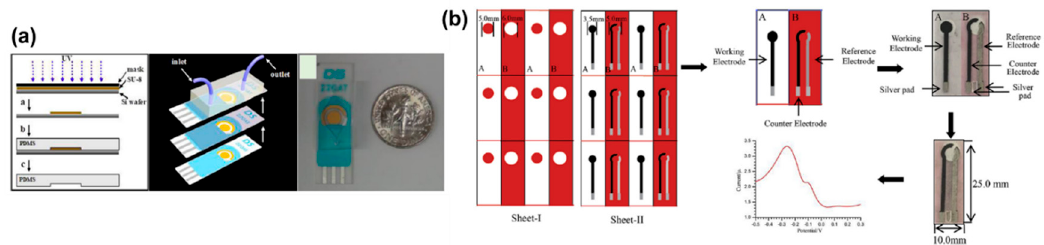
Figure 20. ECBs for the sensitive detection of PSA and cancer antigen 125 (CA125) biomarkers. ( a ) schematics for the fabrication of a microfluidic PSA sensor through screen printing, and size comparison image [237]. ( b ) fabrication of paper-based ECB for CA125 detection [249]. Reprinted with